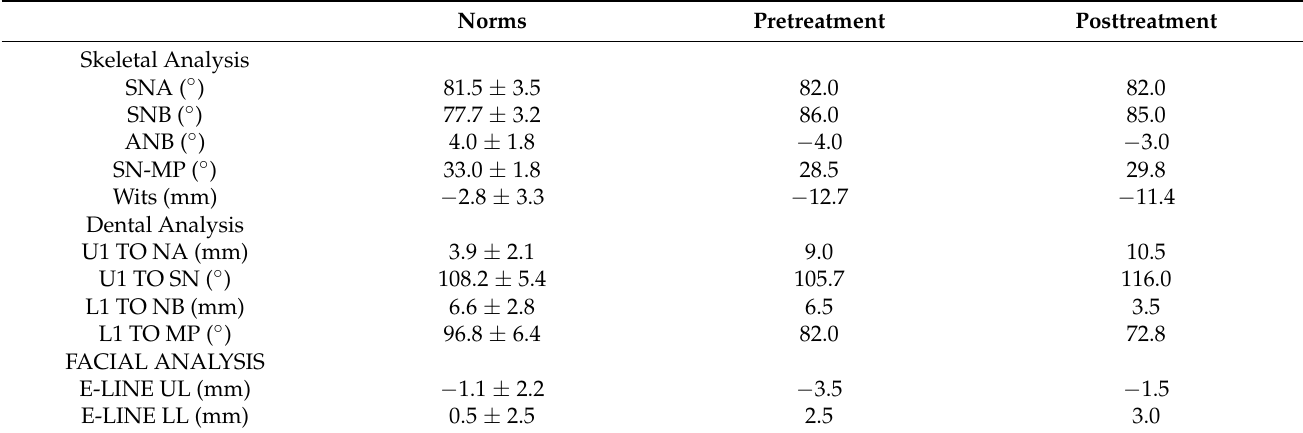
Table 2. Case 2, cephalometric